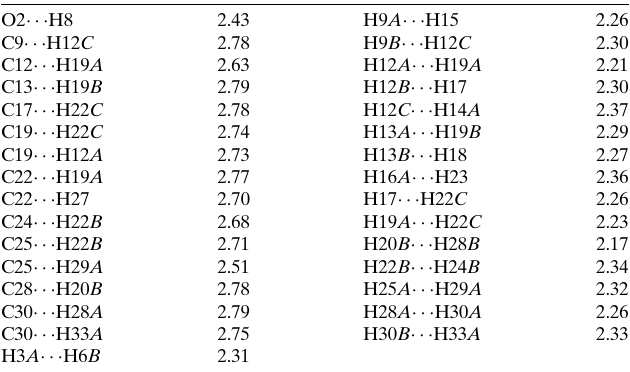
Table 1 Selected interatomic distances (A˚ ).